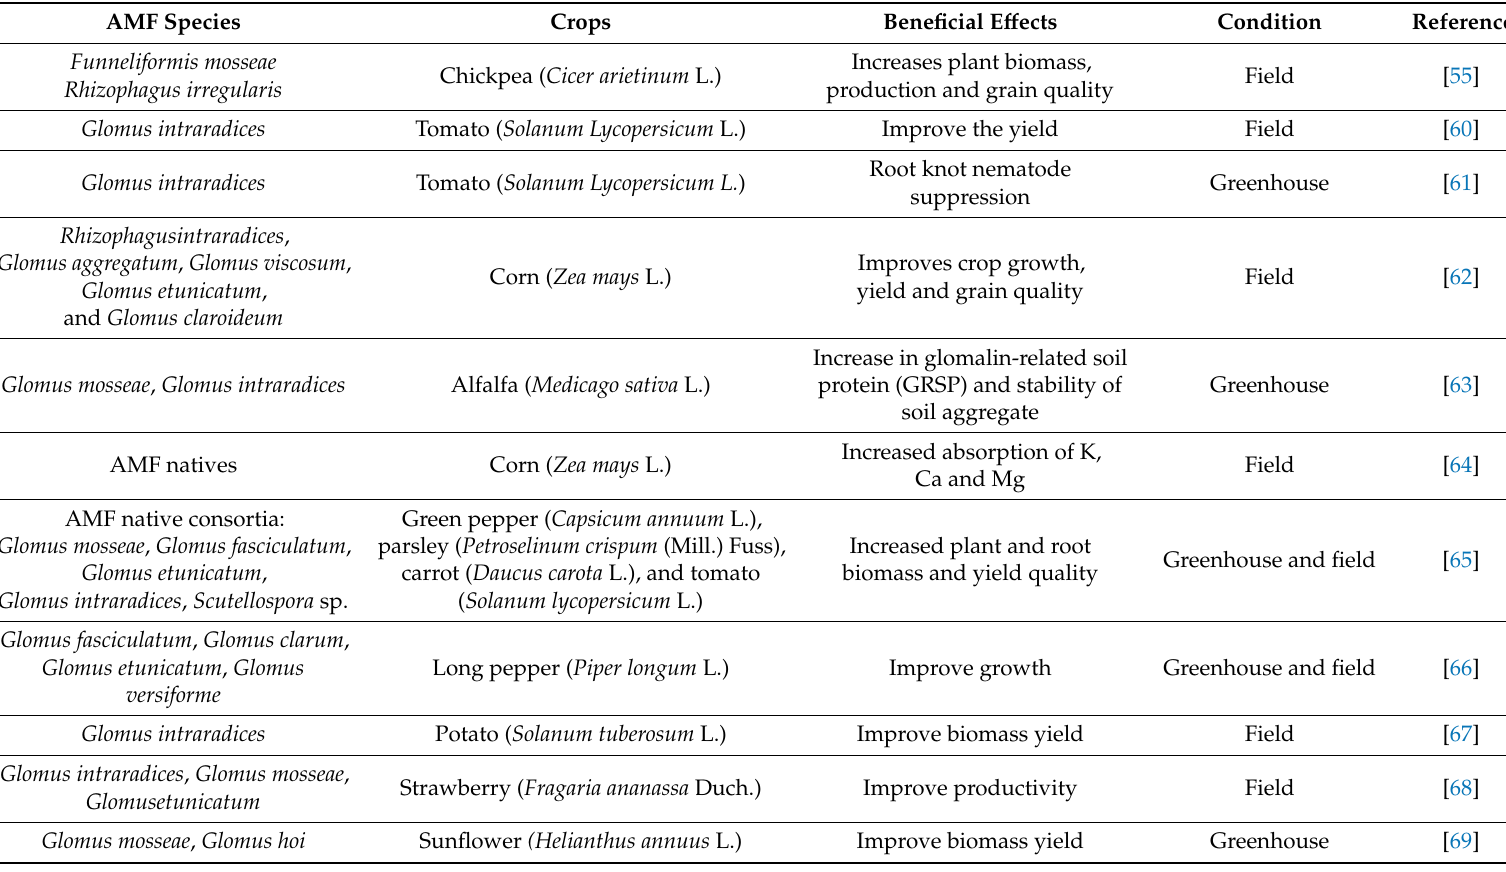
Table 1. Beneficial e ff ects of arbuscular mycorrhizal fungi in agroforestry